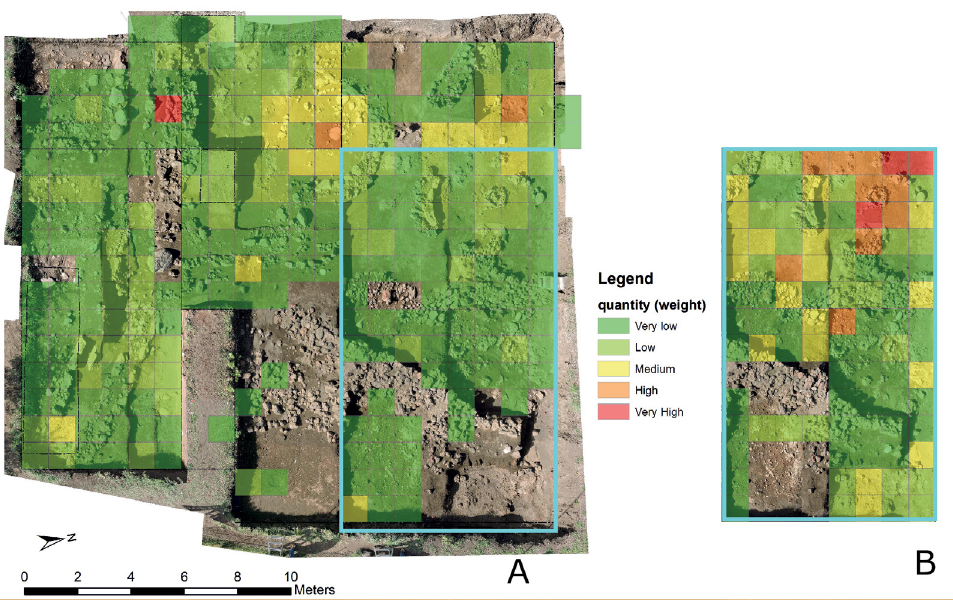
Figure 4. Obsidian distribution in the 1x1 m grid of the excavation (see Fig. 5): A. all the finds in the Western area; B. tools in the Trench 3 (north-east portion of the Western area) (V. Cannavò, A. Di Renzoni).